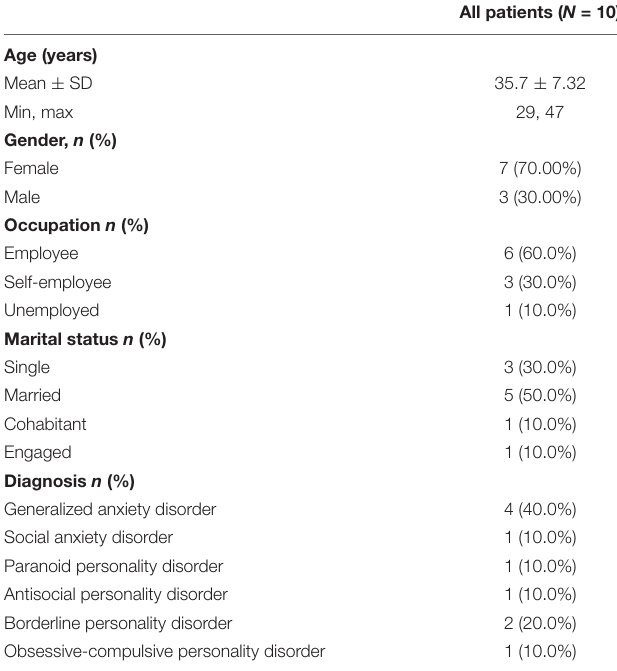
TABLE 1 | Demographic and baseline